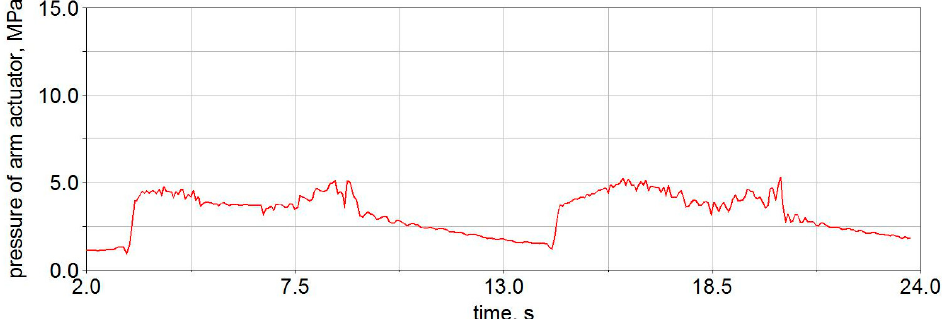
Figure 17. Plot of arm cylinder pressure for manipulator with counterbalance valves and effector